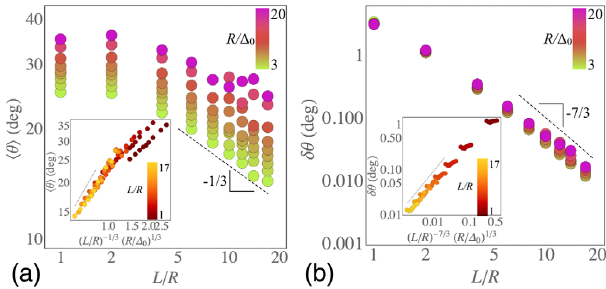
FIG. 8. Plots of (a) the mean tilt angle, and (b) the mean tilt angle deviation, versus bundle aspect ratio L=R . Dotted lines show the power laws predicted from Eq. (22), which follows the limit R= Δ 0 ≫ 1 . Inset plots show the same data plotted versus the dimensionless combinations given in Eq. (22). Note that the double-asymptotic limit of L=R ≫ R= Δ 0 ≫ 1 underlies Eq. (22), highlighted by the yellow data points in these